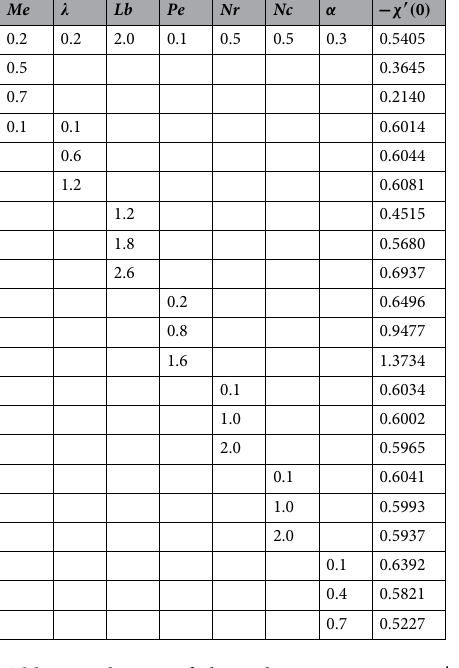
Table 4. Solutions of physical parameters via − χ ′ ( 0 )